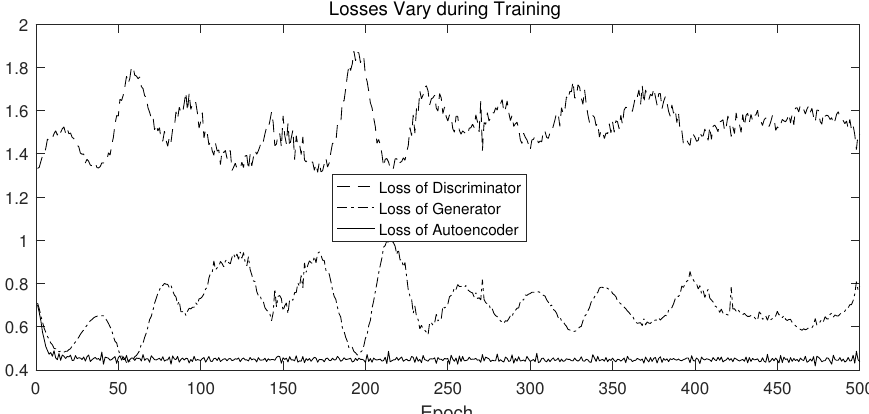
Figure 3. Loss of generator, discriminator, and autoencoder during training: – – represents loss of discriminator fluctuates in range of [1.2, 2.0], – - – - represents the loss of generator fluctuates in range of [0.4, 1.0], —— represents loss of autoencoder fluctuates in range of [0.4, 0.8]. Simultaneously, the AAE gradually and steadily generates higher-quality spectral data, as shown in Figures 4 and 5. With training of the model, the noise of the generated spectral data gradually decreases, the characteristic peaks are more obvious, and the signal-to-noise ratio is significantly improved. The generated spectrum and the measured spectrum are very similar in multiple characteristic peaks, and the generator learned the feature of the original spectral data.